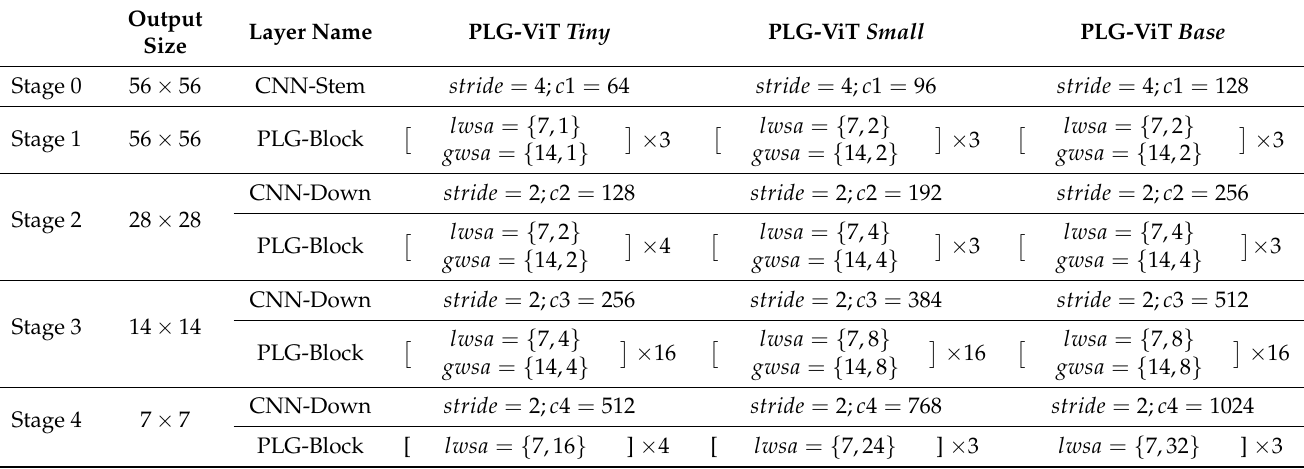
Table A1. Model configurations for our PLG-ViT. There are three configurations introduced: PLG-ViT Tiny , PLG-ViT Small , and PLG-ViT Base , with different model